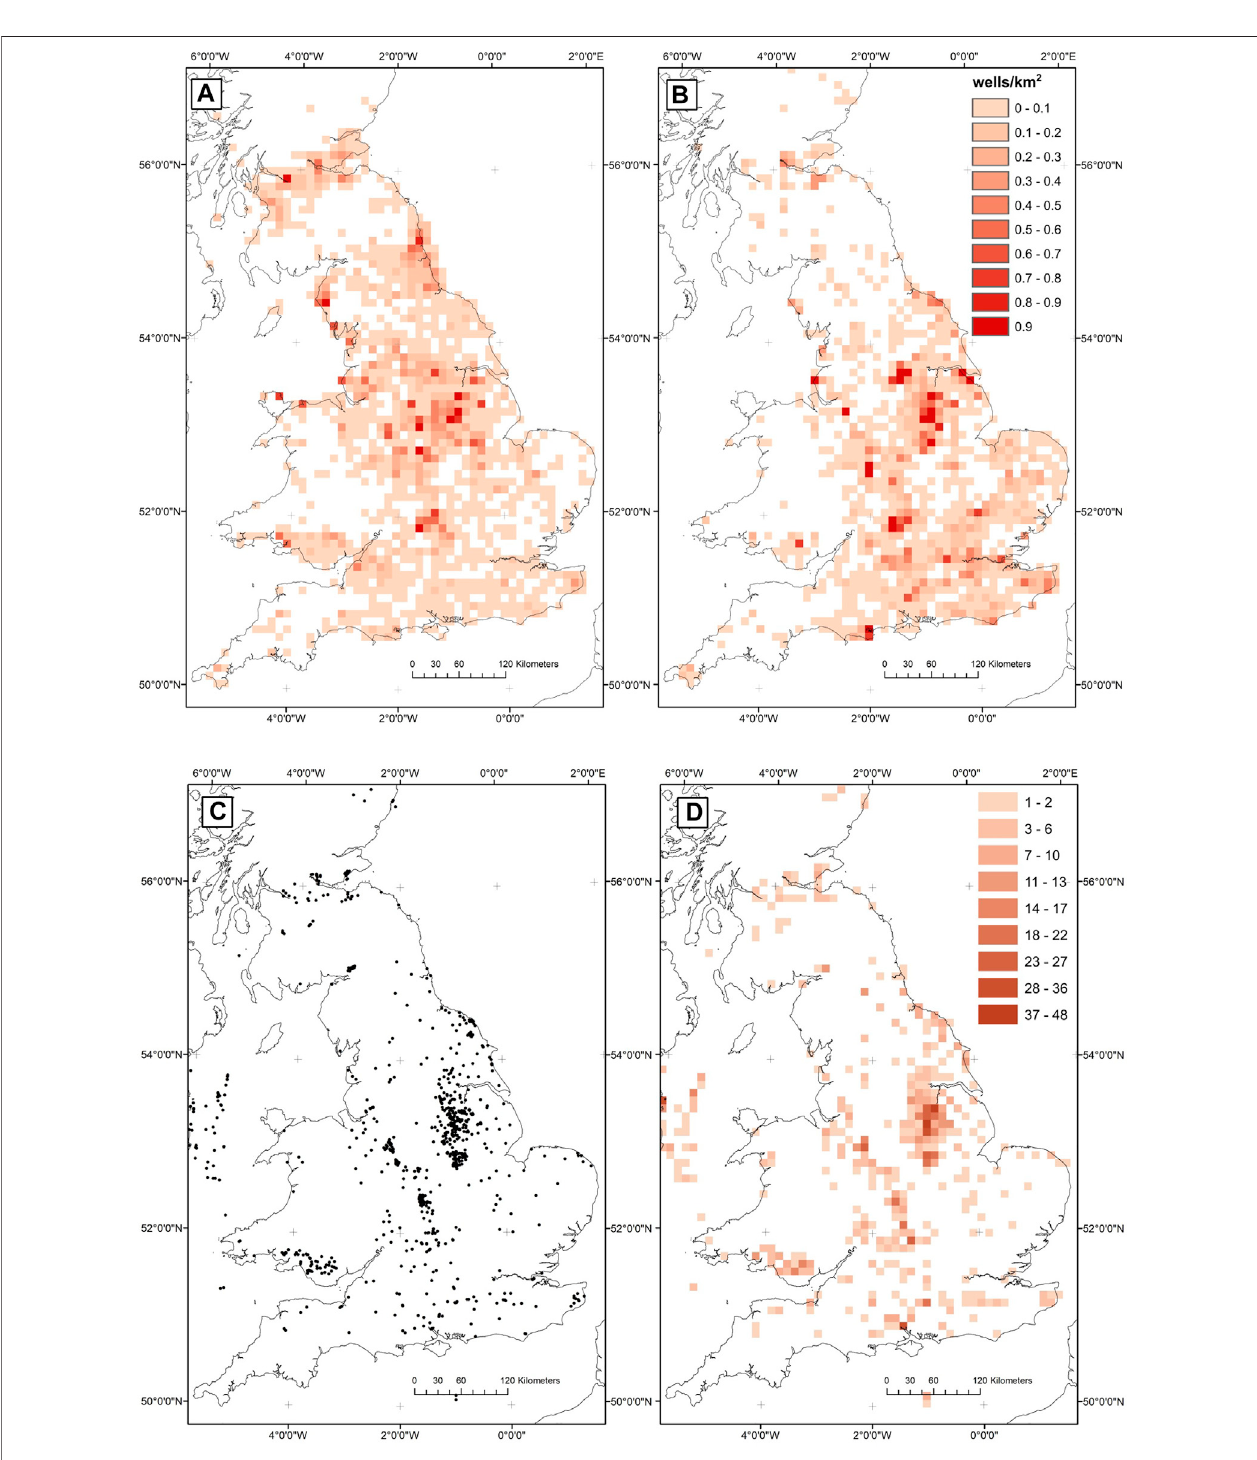
FIGURE 5 | Spatial density of boreholes with (A) geophysical logs and (B) rock samples and maps showing (C) the location of boreholes with temperature measurements and (D) the number of temperature measurements per 10 km 2 .